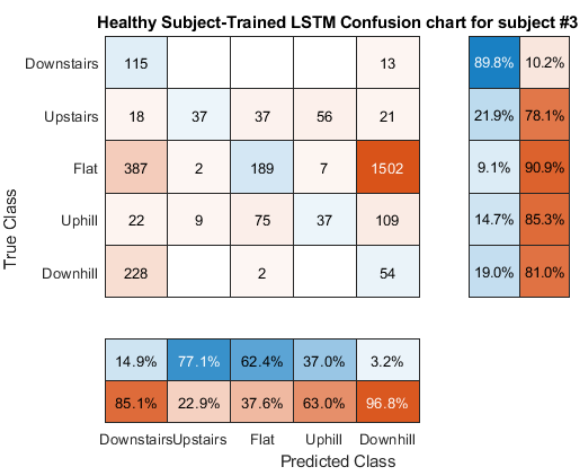
Figure A16. Long Short-Term Memory Network Confusion Chart for ILLA participant A2 as trained by healthy individuals.